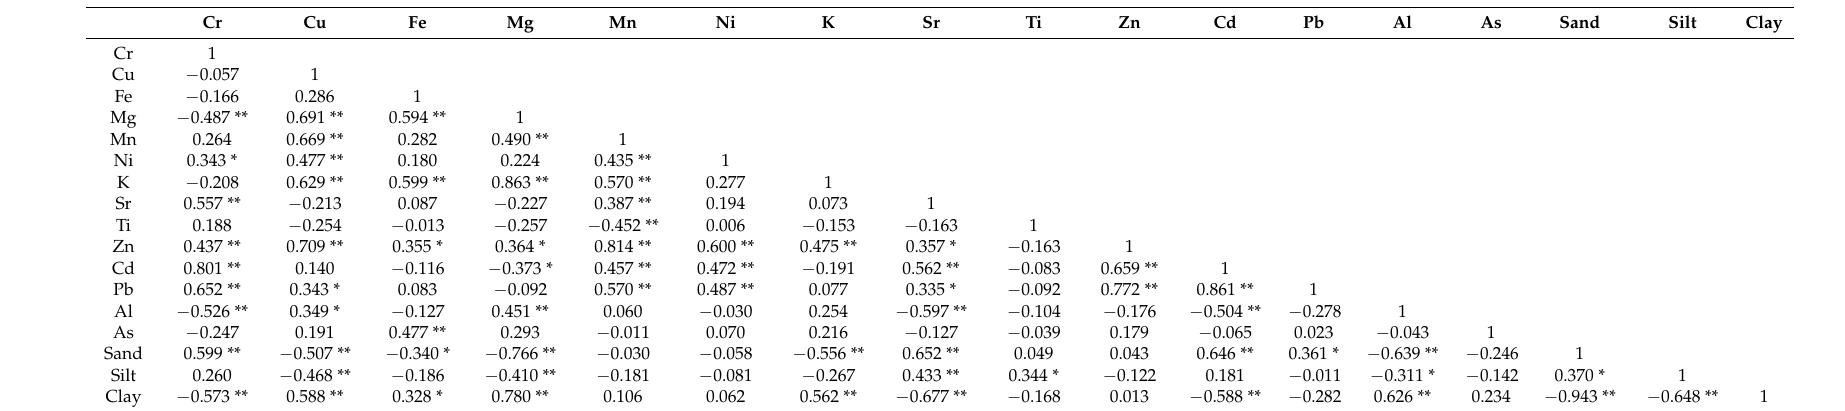
Table 2. Pearson’s correlation of metal concentrations for Lake Taihu sedimentary